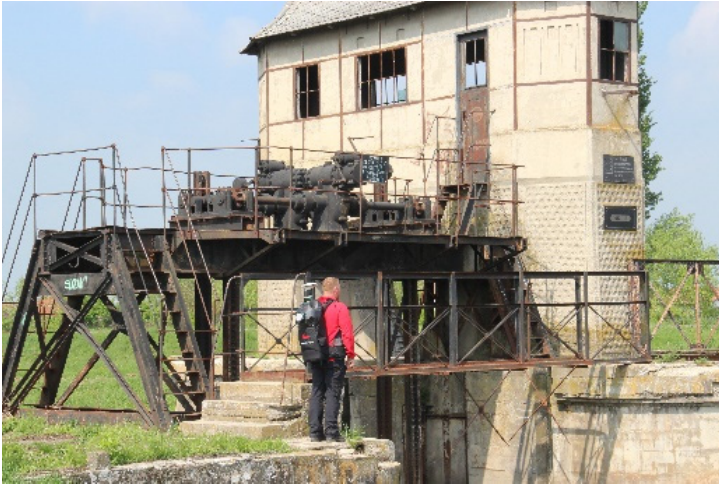
Figure 6. Performing a ZUPT outdoors during the scan (Sânmihaiu Român).